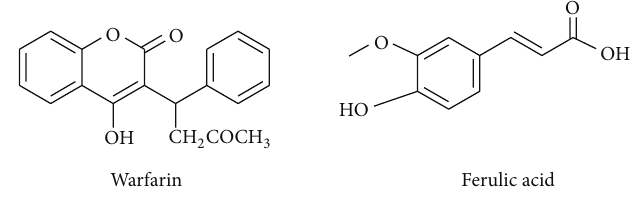
Figure 1: The tentative structure of warfarin and ferulic